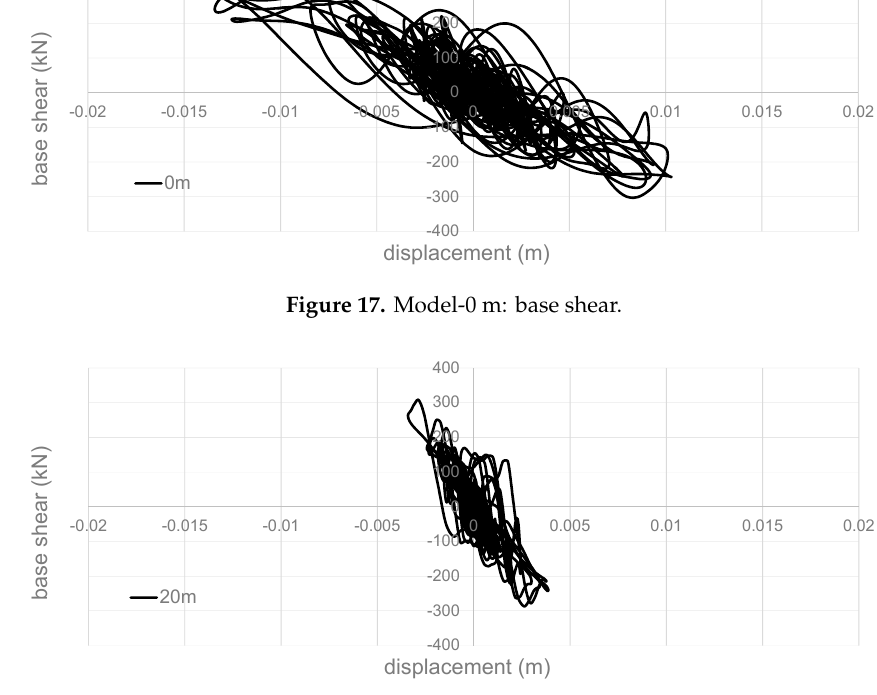
Figure 18. Model-20 m: base shear.